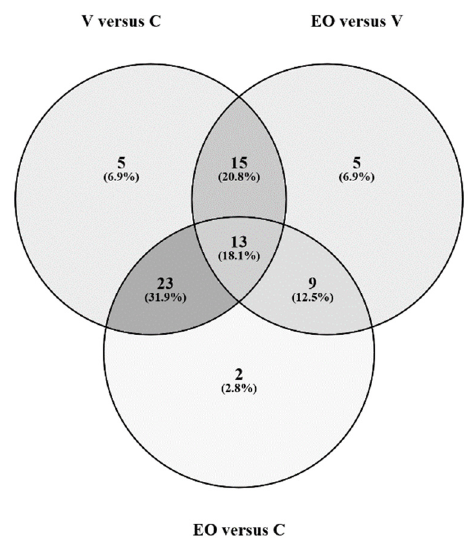
9 metabolites distinguishing the EO group. The complete list of metabolites is presented as supplementary data (Table S4).